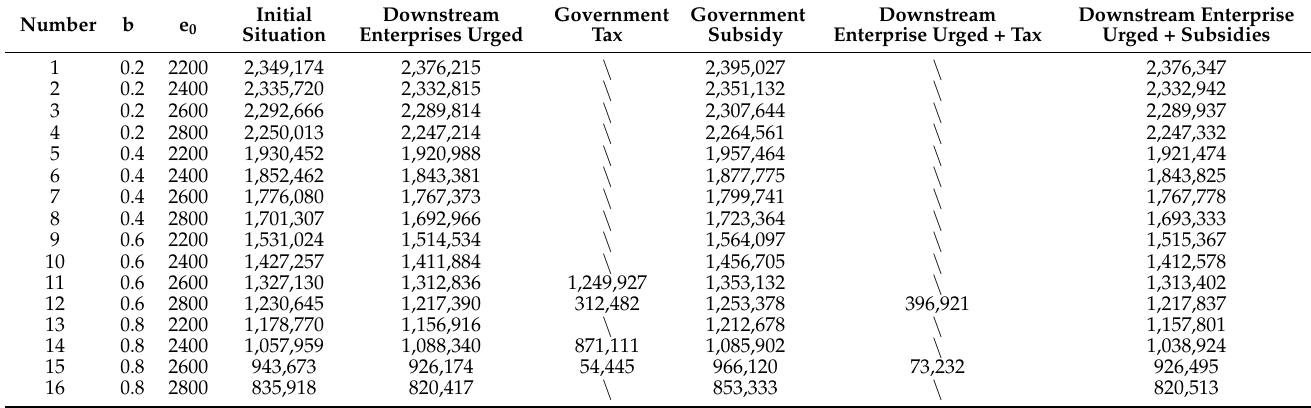
Table 3. The choice of downstream enterprises under different government policies. Government Policy Downstream Enterprises Subsidies to suppliers Will not urge suppliers to reduce emissions Urges its emission reduction (number 12, 15) Tax on suppliers Do not urge its emission reduction (number 11,